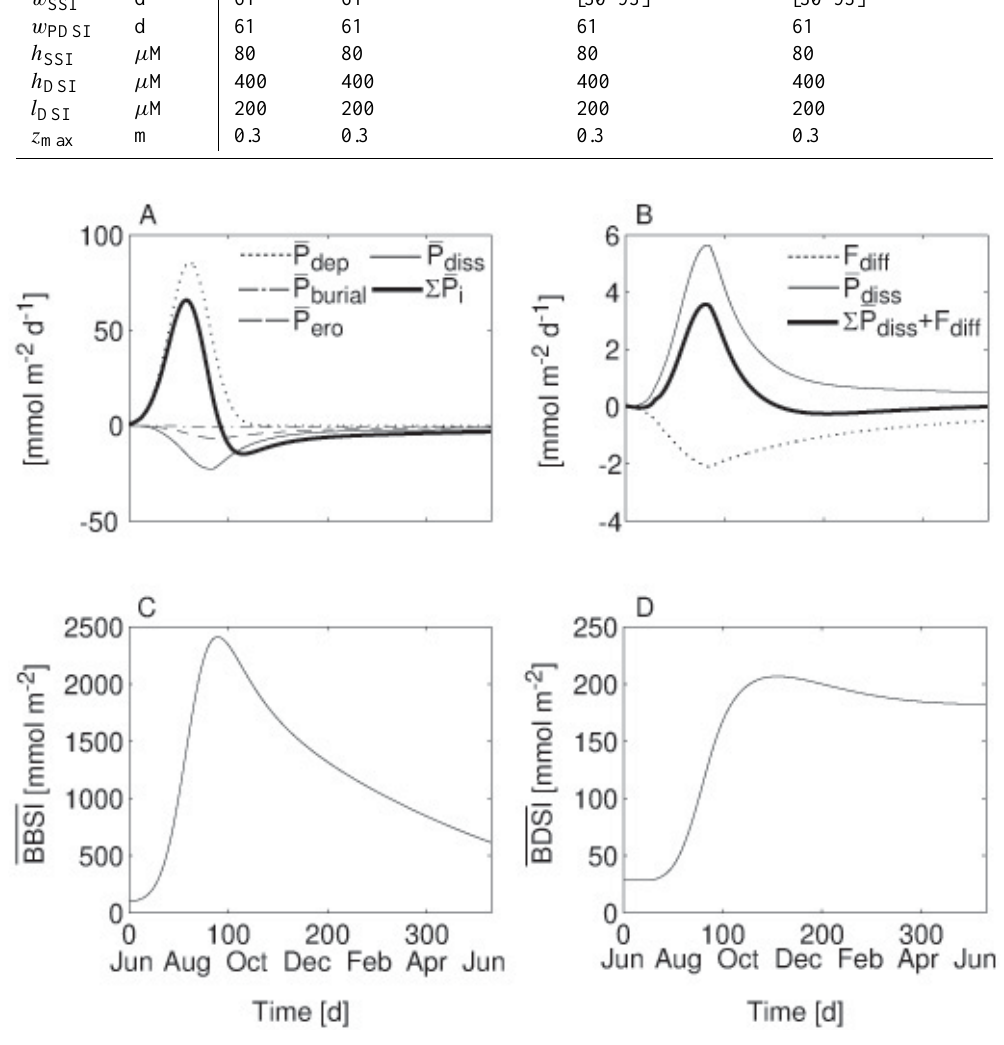
Fig. 3. Temporal evolution of depth-integrated (A) deposition flux P dep , erosion flux P ero , burial flux P burial , dissolution rate of biogenic silica P diss and net rate P i P i , (B) depth-integrated dissolution rate P diss , diffusive flux F diff , and net rate P P diss − F diff (C) depth- integrated biogenic silica content in the sediments BBSI and (D) depth-integrated dissolved silica concentration BDSI. Simulation results correspond to the baseline parameter set (Table 2) R F diff of BDSI (Fig. 4e, the time-integrated diffusive flux